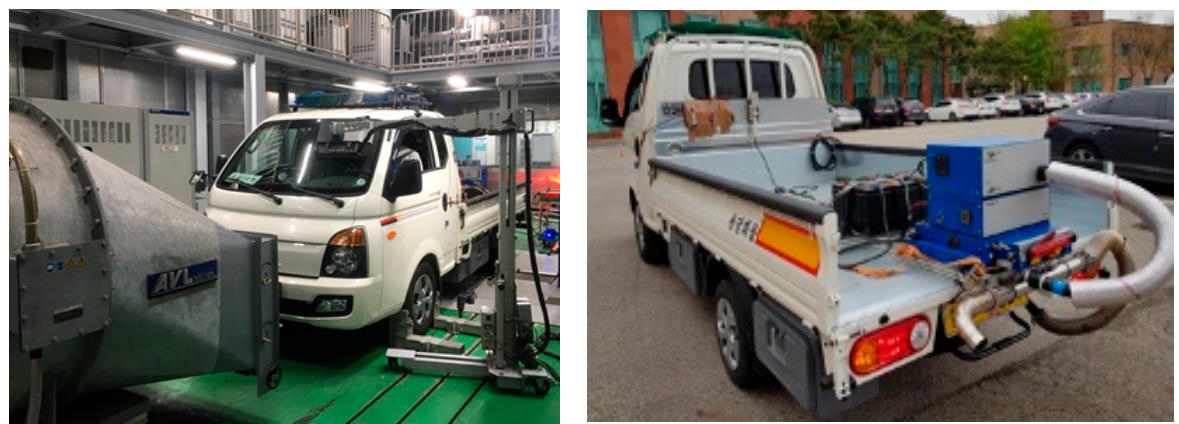
Figure 1. Emission tests on a chassis dynamometer in a laboratory and real driving conditions.